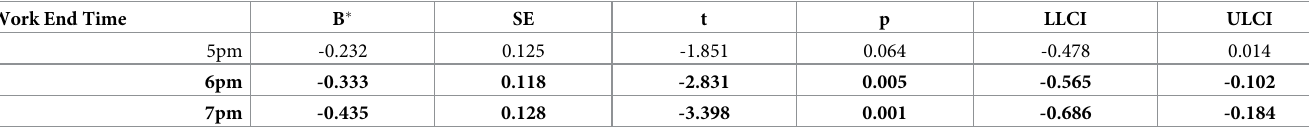
(cid:3) Values of B for non z-standardized independent and dependent